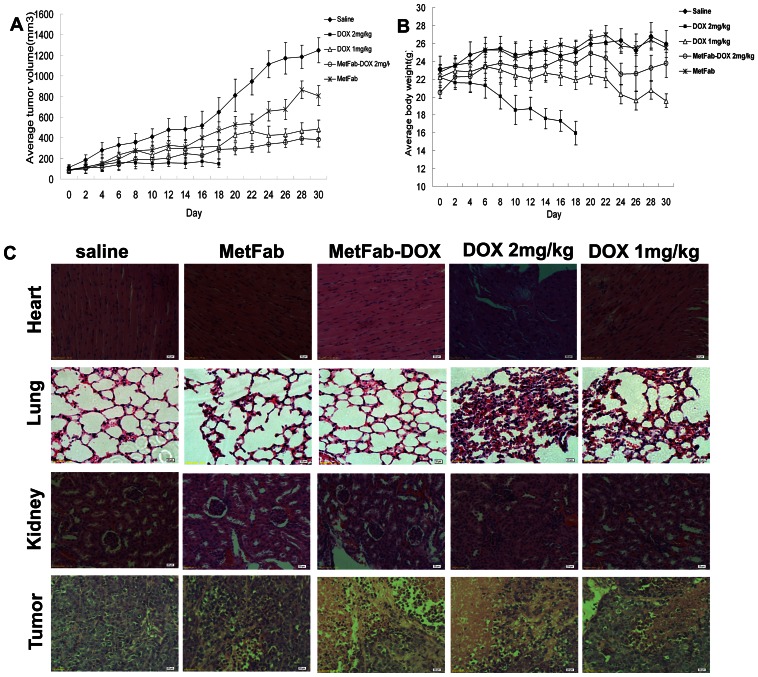
Tumor inhibition assay in mice bearing HepG2 xenograft.(A, B): Subcutaneous tumors were established in mice inoculated with HepG2 cells. Animals were given i.p. injection of DOX and MetFab-DOX at the indicated doses every two days for 15 injections, except that the mice treated with 2 mg/kg DOX died after 10th injection. The mice injected with saline were as control, and the MetFab was given at the same antibody concentration as MetFab-DOX. The average tumor volumes (A) and mice body weight (B) were determined from 8 animals per group. (A) There were significant differences in tumor growth among groups (P<0.001). The growth of tumors was inhibited by free DOX, MetFab-DOX and MetFab when compared with saline (P<0.001). There was no significant difference in tumor volume between the MetFab-DOX and high-dose DOX treatments with equivalent doxorubicin dosage (P = 0.08). (B) There were significant differences in body weight between groups treated with DOX and any other reagents (P<0.001). High-dose or low-dose DOX treatment resulted in a significant reduction of body weight compared to MetFab-DOX treatment (P<0.001). There was no significant difference in body weight between MetFab and saline treatment. (C)The tissue pathological observation of nude mice bearing HepG2 cells after different treatments. All the tissue sections were prepared by HE staining. There were significant pathological changes in heart, lung and kidney in mice treated with free DOX. And there was inapparent necrosis in tumor tissue of saline group, while profound necrosis and bleeding in tumors of DOX and MetFab-DOX group.